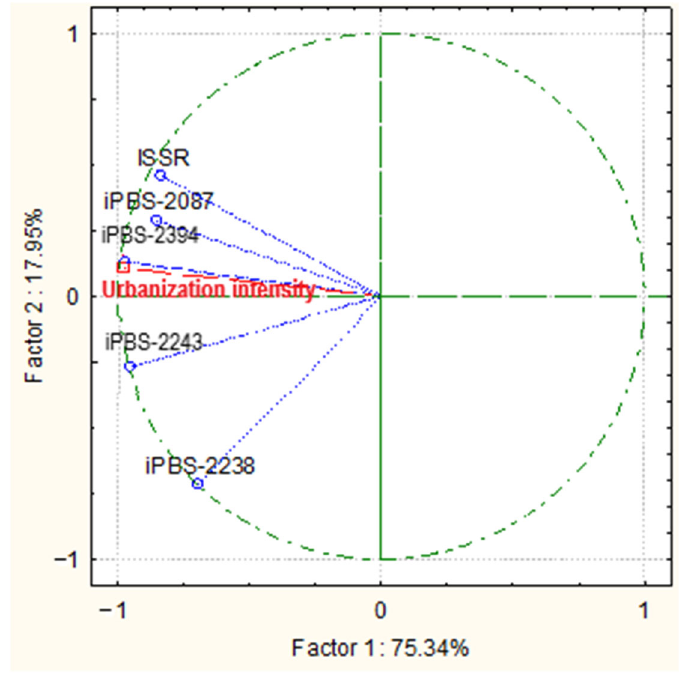
Figure 10. Bi-plot graph resulting from principal component analysis (PCA) showing the correlation between measured variables (iPBS and ISSR molecular markers) and urbanization intensity. between measured variables (iPBS and ISSR molecular markers) and urbanization